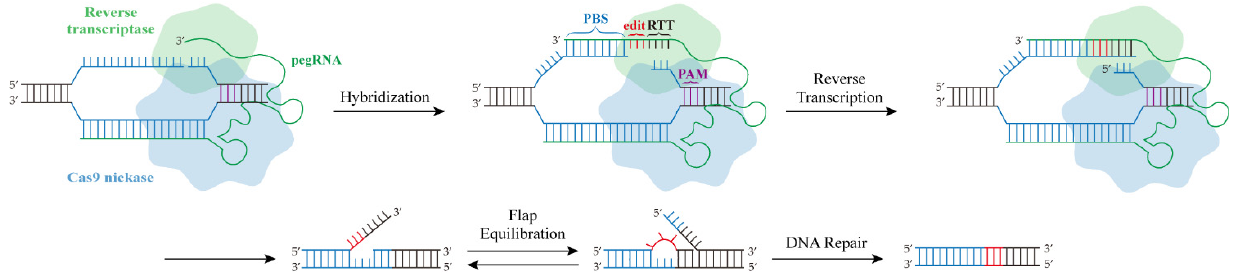
Figure 1. Principle of the PE system. dCas9 binds the target DNA under the guidance of pegRNA and nicks the PAM-containing strand. The hybridization of the exposed 3 ′ end to the PBS primes the reverse transcription of the nicked DNA strand for the desired edit. Given the preference for the 3 ′ flap, the 5 ′ flap cleavages and DNA repair installs the desired edit.